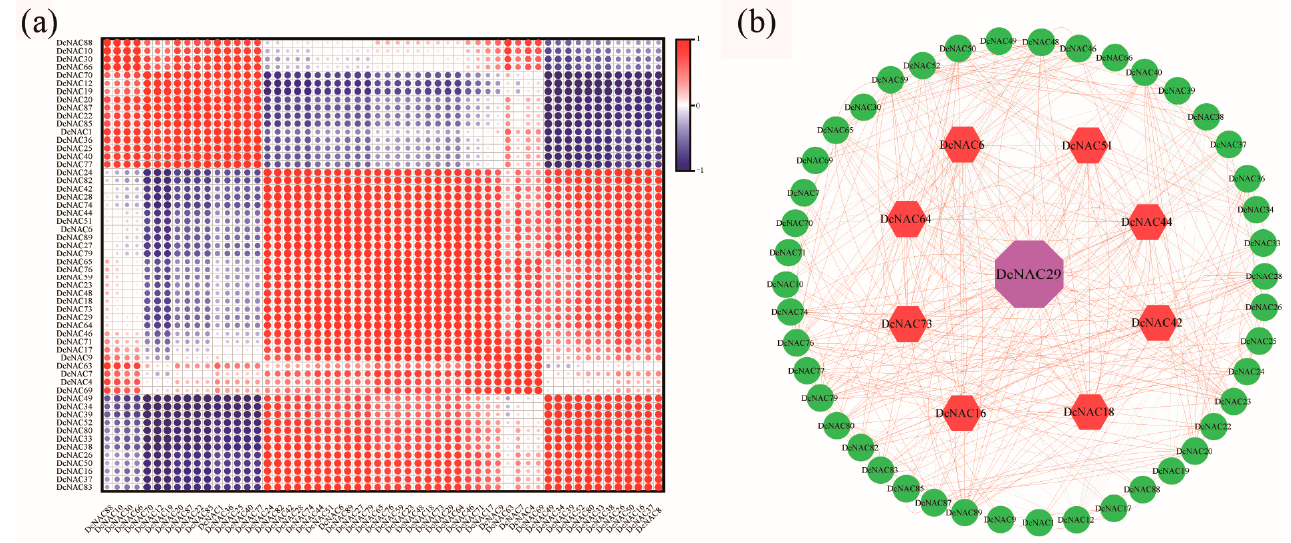
Figure 7. Comprehensive analysis of drought-related DcNAC genes. ( a ) Correlation analysis of upregulated DcNAC genes. Red indicates a positive correlation, and blue indicates a negative correlation. The circle size indicates the absolute value of the correlation coefficient. ( b ) Co-expression network analysis. The red line represents a positive correlation. The size represents the degree calculated by the Cytoscape.